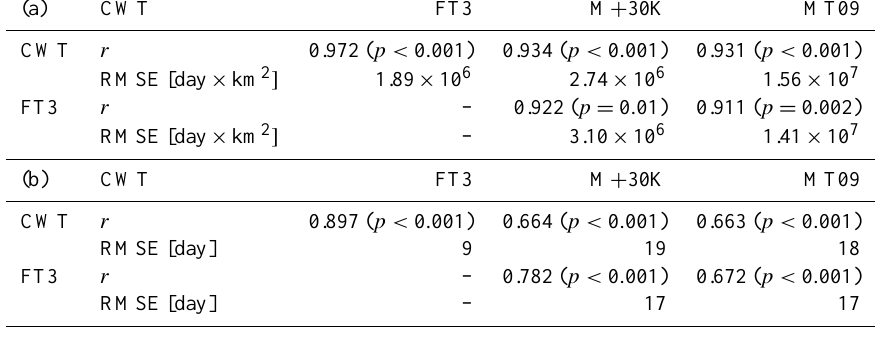
Table 2. The correlation ( r ) and the root-mean-squared error (RMSE) between surface melting data sets for (a) seasonally integrated melting index (b) and spatially coincident mean melting duration.